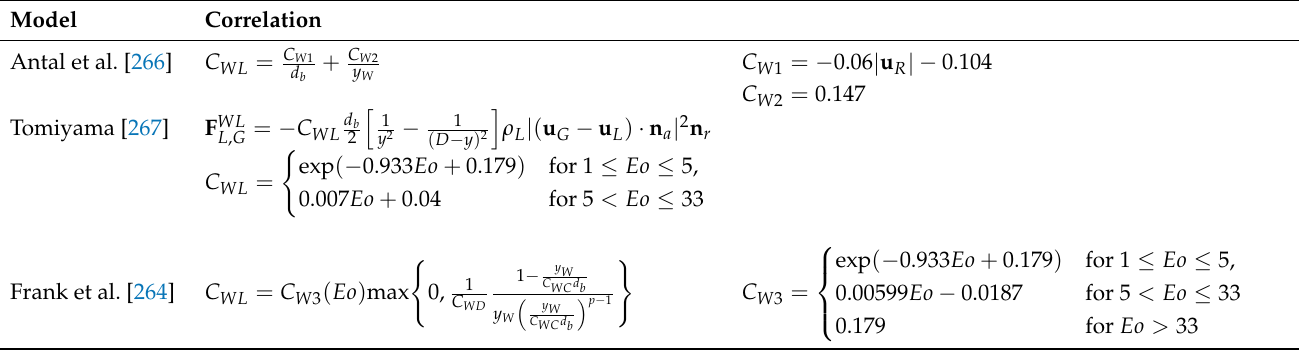
Table 9. Wall lubrication force coefficient correlations. Note that in the model of Tomiyama the wall lubrication force is differently defined as in (20).